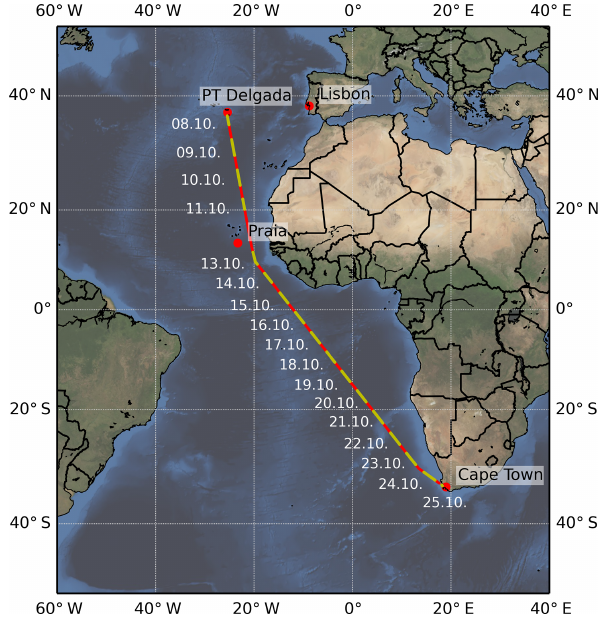
Figure 2. Cruise track (red) of MSM58/2 from Ponta Delgada (Azores) to Cape Town (South Africa). Times when the instrument was measuring are marked in yellow. On 12 October 2016, no mea- surements could be